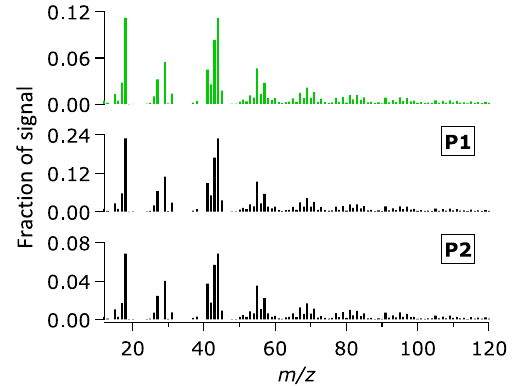
Figure 3. Average mass spectra of OA during the entire sampling period (top) and the P1 and P2